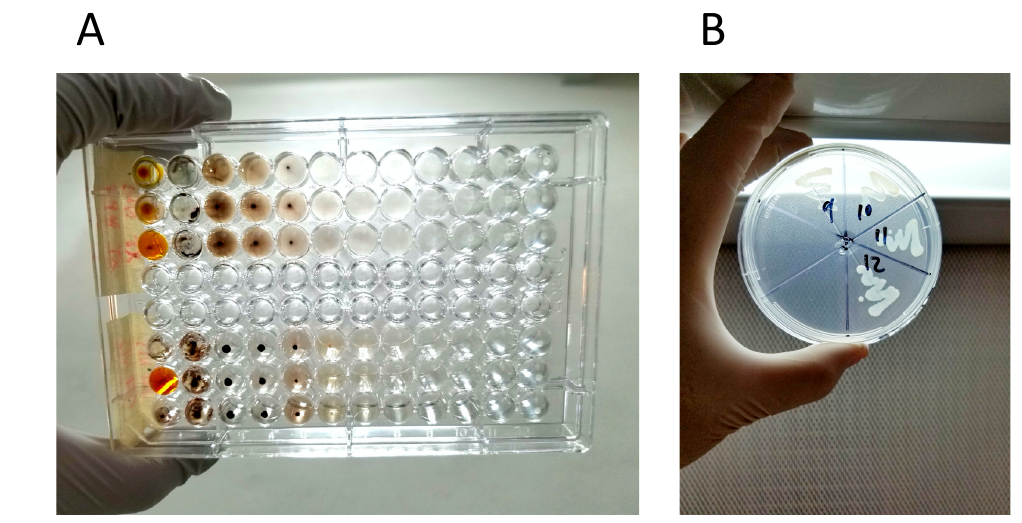
Figure 4. Determination of the ( A ) MIC and ( B ) MBC.